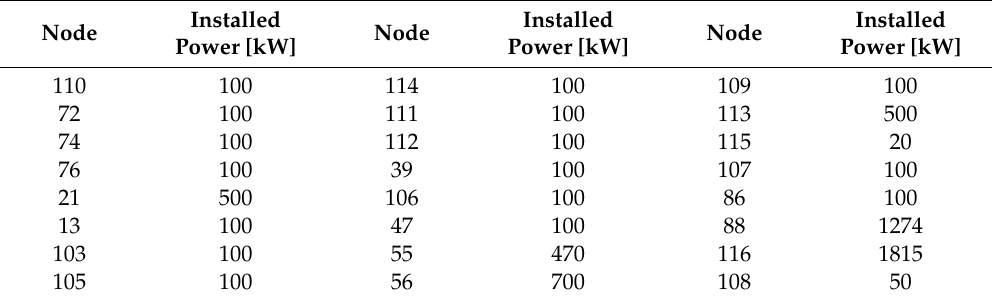
Table 3. Renewable energy sources at every